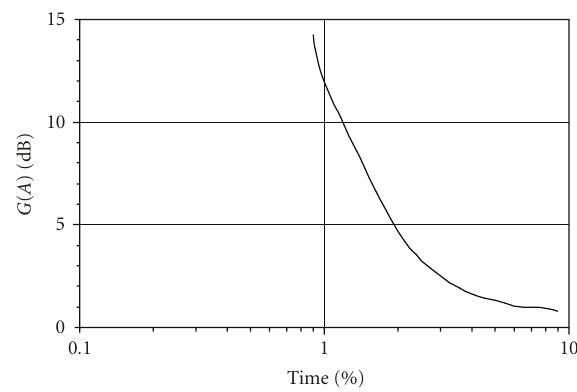
Figure 17: Obtained diversity